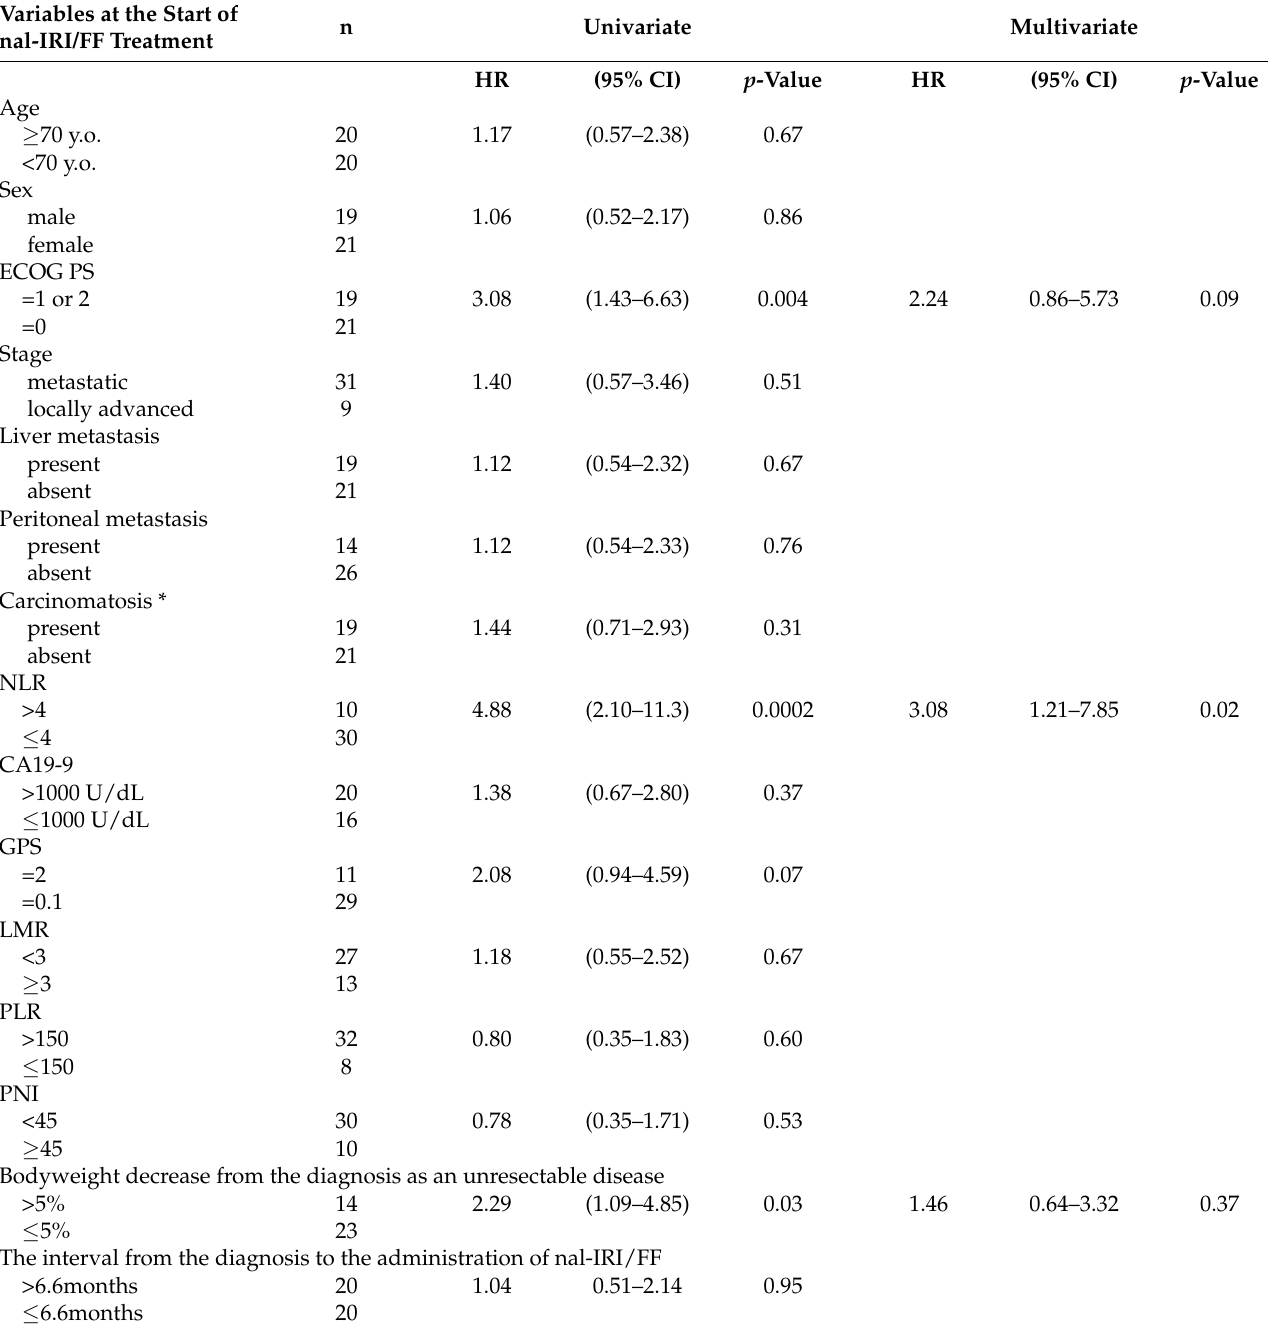
Table 5. Univariate and multivariate analyses of clinical factors at the start of irinotecan plus fluorouracil/folinic acid (nal-IRI/FF) treatment for predicting overall